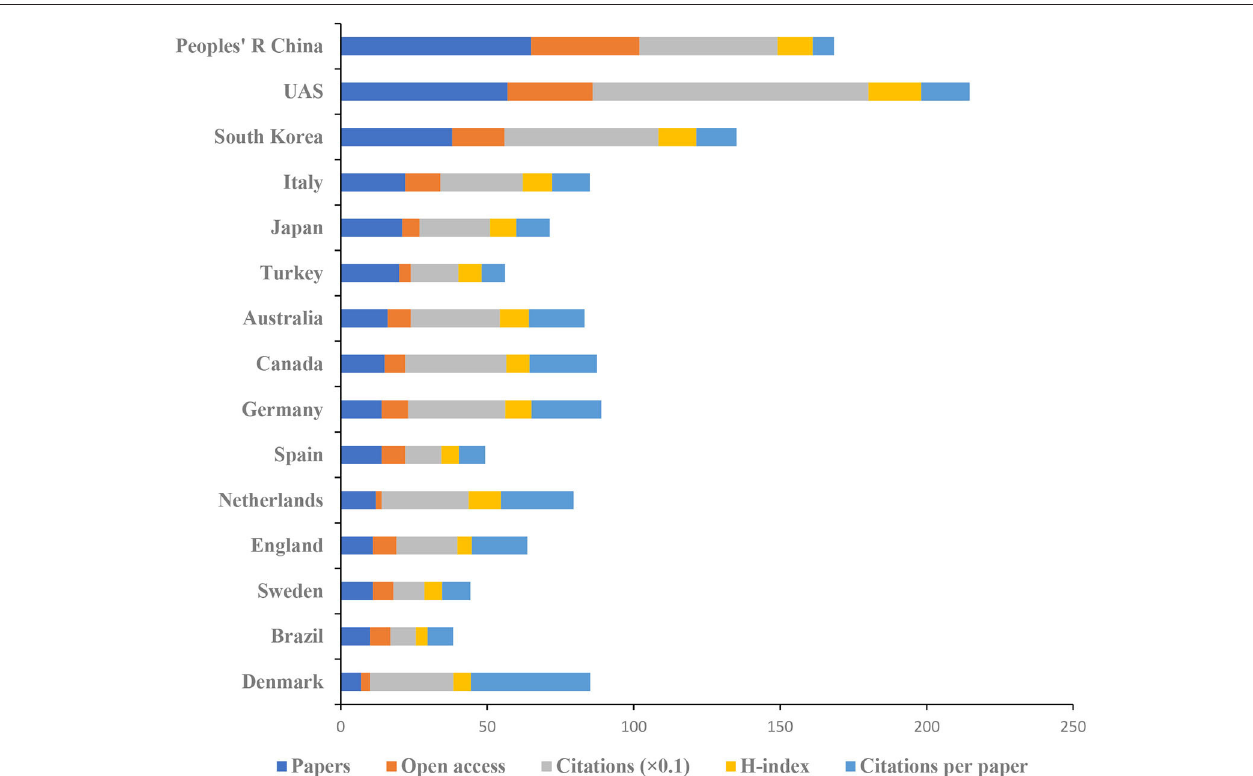
FIGURE 7 | The number of articles, citations, citations per article, and open-access articles, and H-index of the top 15 countries.